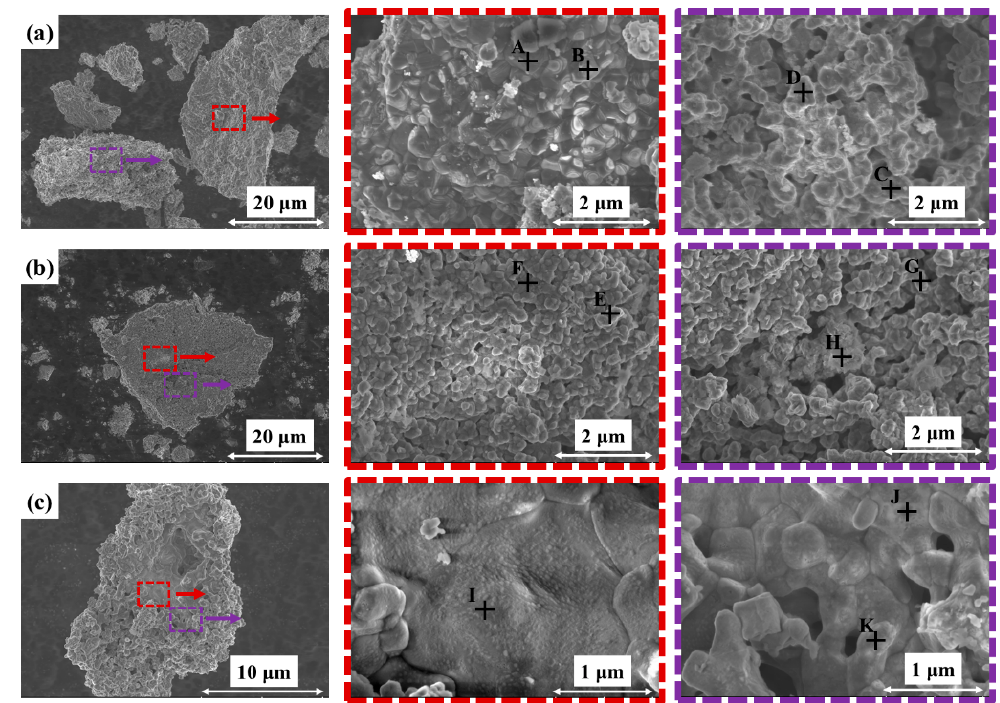
Figure 4. SEM photos for SHS products of the Mg-TiO 2 system at different sample preparation pressures: ( a ) 25; ( b ) 75; ( c ) 150 MPa. Table 2. EDS results of SHS products at di ff erent sample preparation